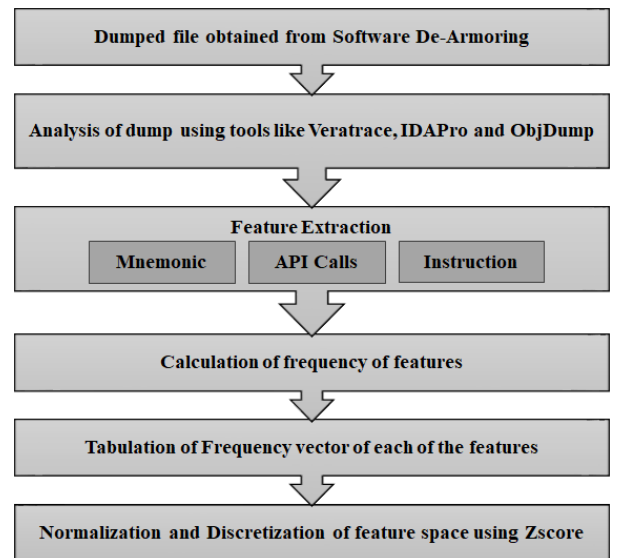
Figure 2. Feature